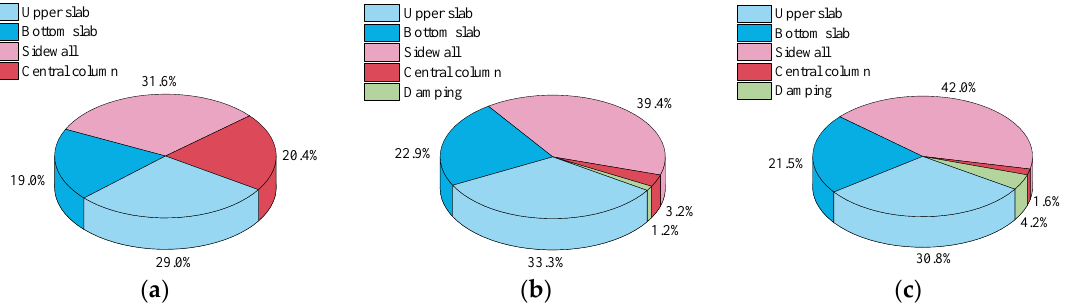
Figure 15. Energy-dissipation proportion for ( a ) uncontrolled US, ( b ) US-CIS and ( c ) US-NSAS isolation system. Table 6. Maximal plastic-energy density for different parts of underground structure (US).